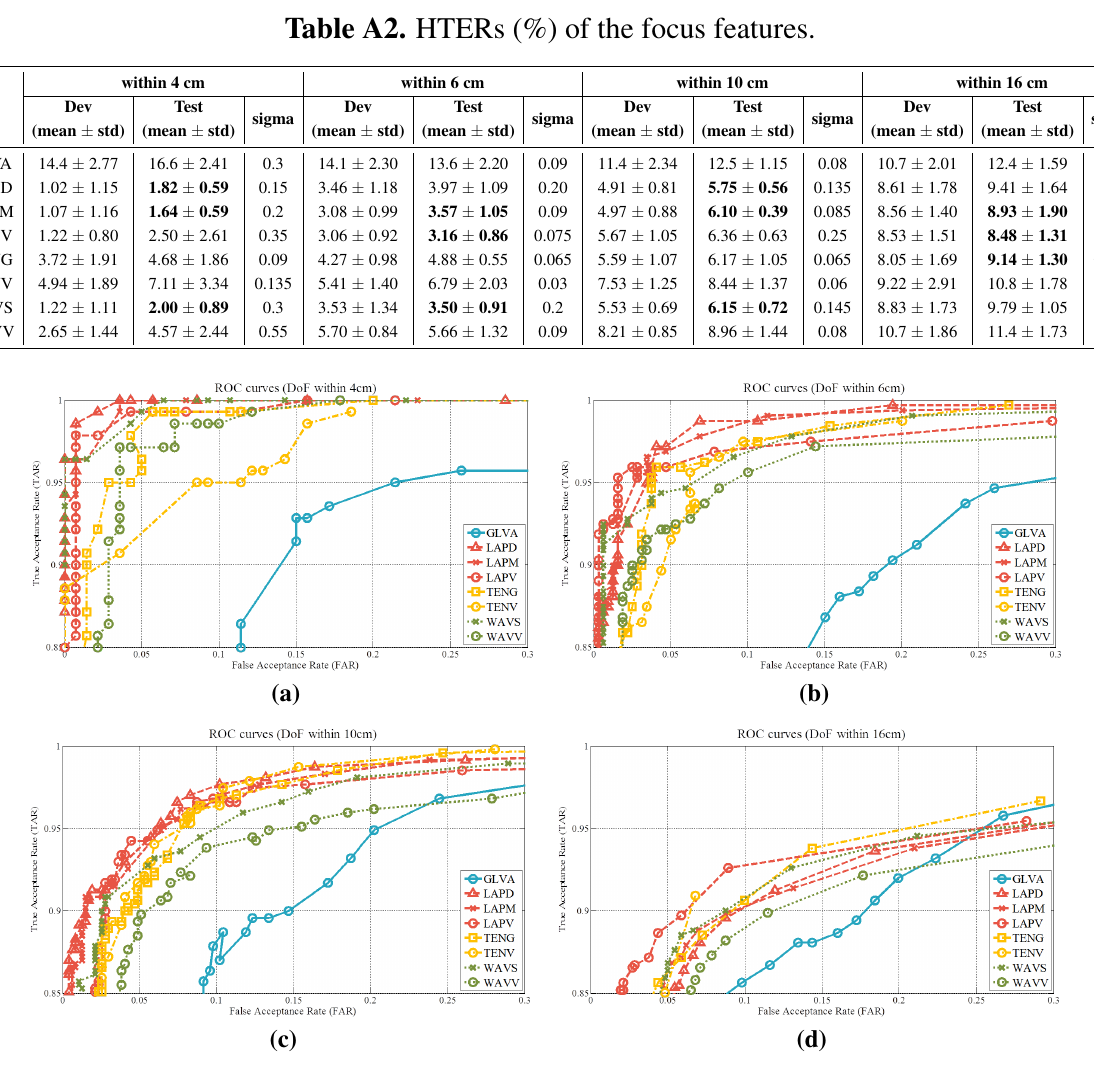
Figure A1. ROC curves of the focus features (DoF ( a ) within 4 cm, ( b ) within 6 cm, ( c ) within 10 cm and ( d ) within 16